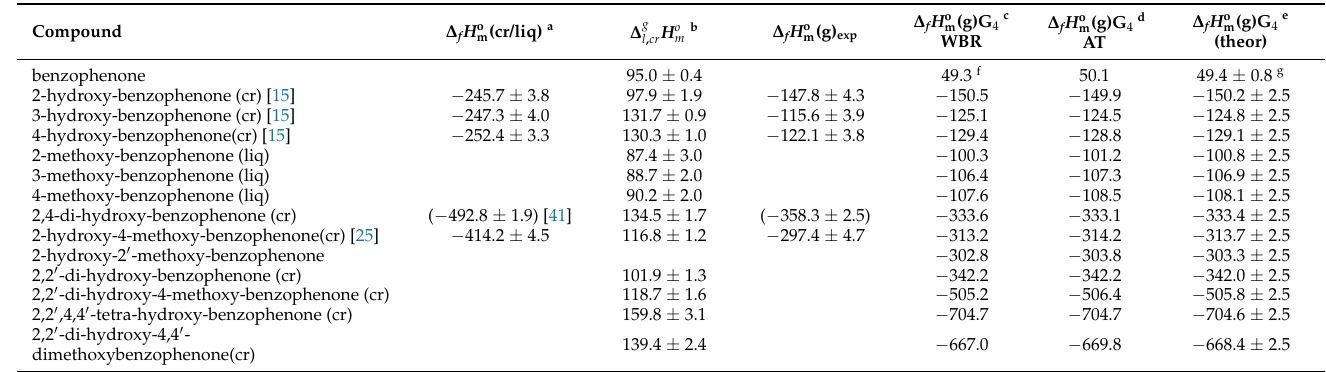
Table 8. Thermochemical data for substituted benzophenones at T = 298.15 K ( p ◦ = 0.1 MPa) (in kJ · mol − 1 ) a .